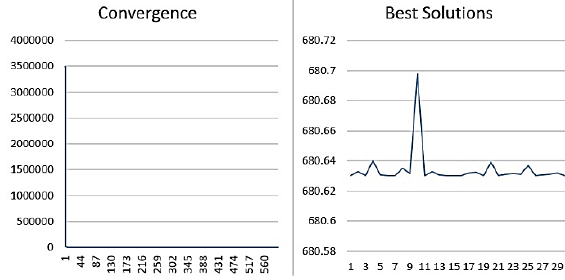
Figure 9. Convergence curve and 30 best solutions for